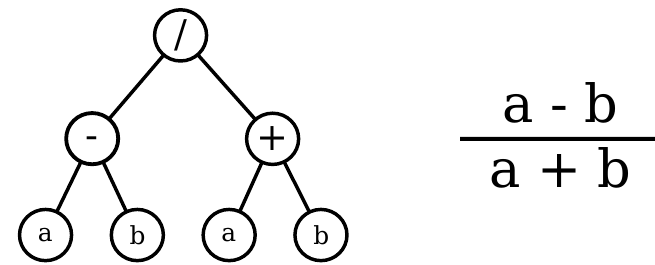
Figure 2. Genotype ( left ) and phenotype ( right ) of a mathematical formula.